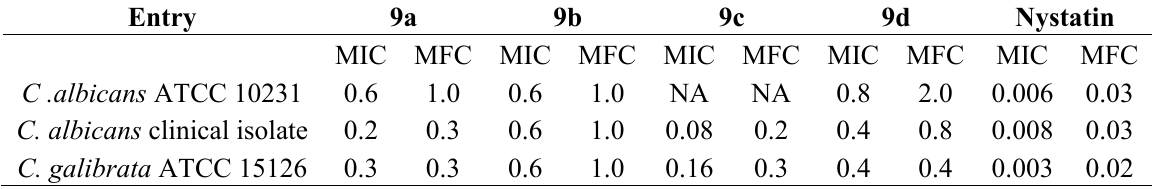
Table 3. The MIC and MFC in mg/mL for compounds ( 9a – d ) against Candida species.